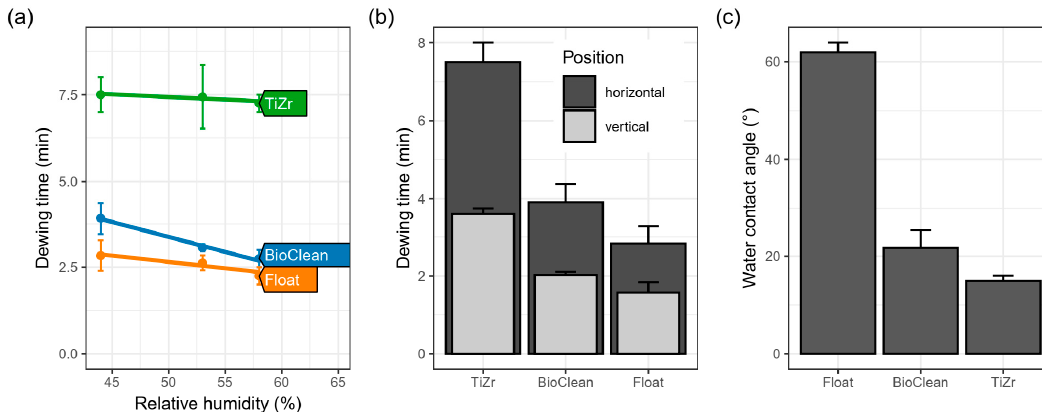
Figure 5. Dependence of time of formation of water droplets (condensation) on the relative humidity across samples ( a ), dependence on the orientation of the sample ( b ) and water contact angles of the pristine samples ( c ). Solid lines in ( a ) represent the linear correlation fitting to data.